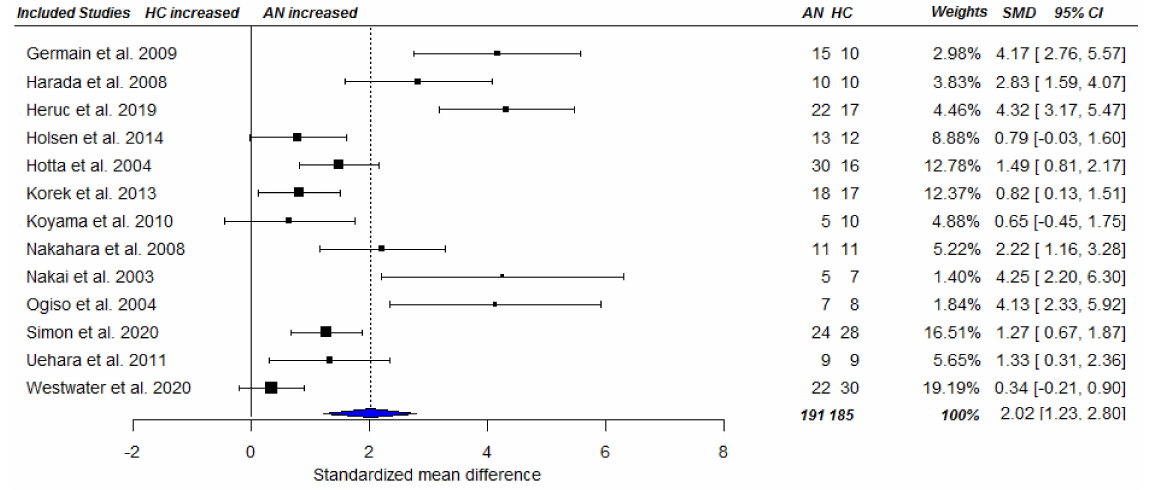
Figure 3. Forest plot of cross-sectional comparison of AN patients at baseline (pre-treatment; T1) and HCs on acyl ghrelin. AN = anorexia nervosa; HC = healthy control; SMD = standardized mean difference, CI = confidence interval.